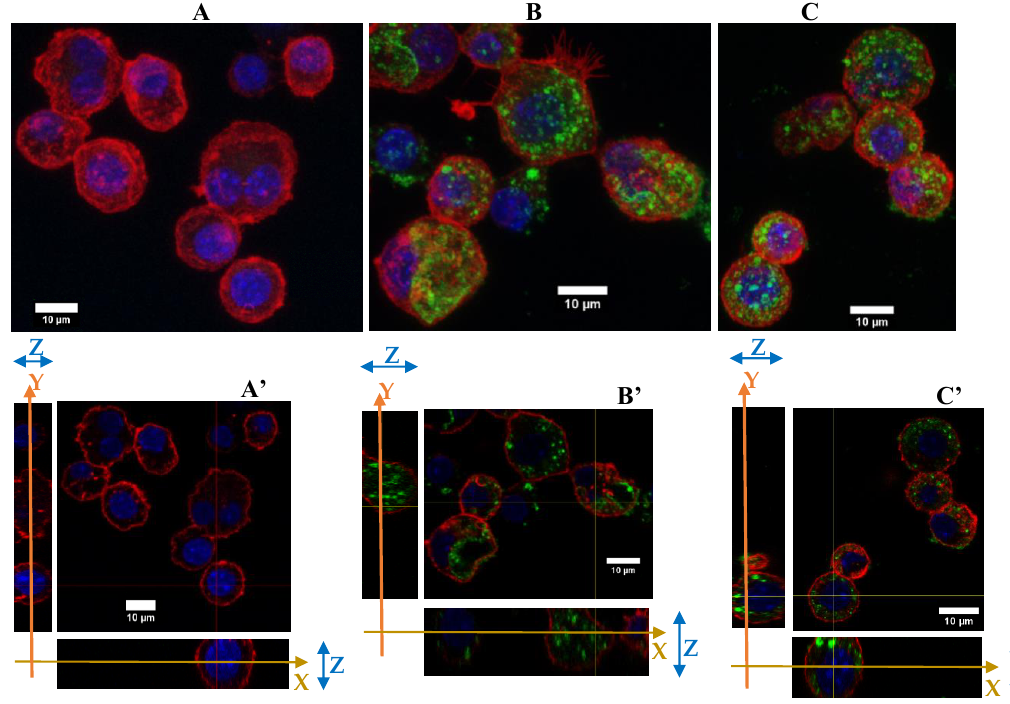
Figure 4. Green silica internalization and cytoskeleton changes of RAW264.7 cells after chronic and acute exposure. ( A – C ) Control and green silica internalization of cells exposed chronically to 5 µg/mL during 4 days, and 10 µg/mL during 24 h, respectively, obtained by confocal microscopy (nucleus in blue (DAPI), actin in red (phalloidin-atto 550), silica in green (FITC), n = 2. Z-project reconstitution. ( A’ – C’ ) Same conditions as previously, represented in orthogonal views. The actin cell membrane is labeled in red by phalloidin-atto550, the nucleus is labeled in blue and the silica nanoparticles are green fluorescent. The stack of the cells corresponding to a slice in the thickness of the cells is illustrated. The combination of the XY and YZ confocal plans demonstrate the internalization of the silica nanoparticles.